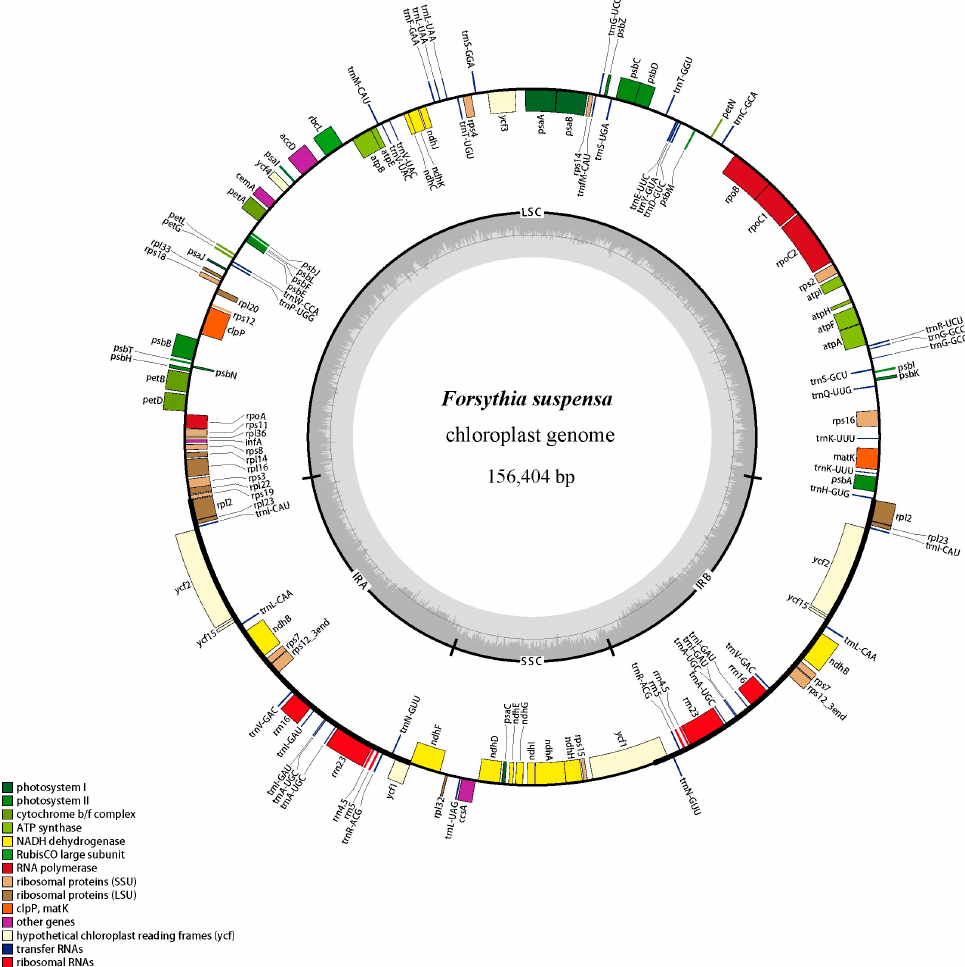
Figure 1. Chloroplast genome map of Forsythia suspensa . Genes drawn inside the circle are transcribed clockwise, and those outside are counterclockwise. Genes are color-coded based on their function, which are shown at the left bottom. The inner circle indicates the inverted boundaries and GC content.